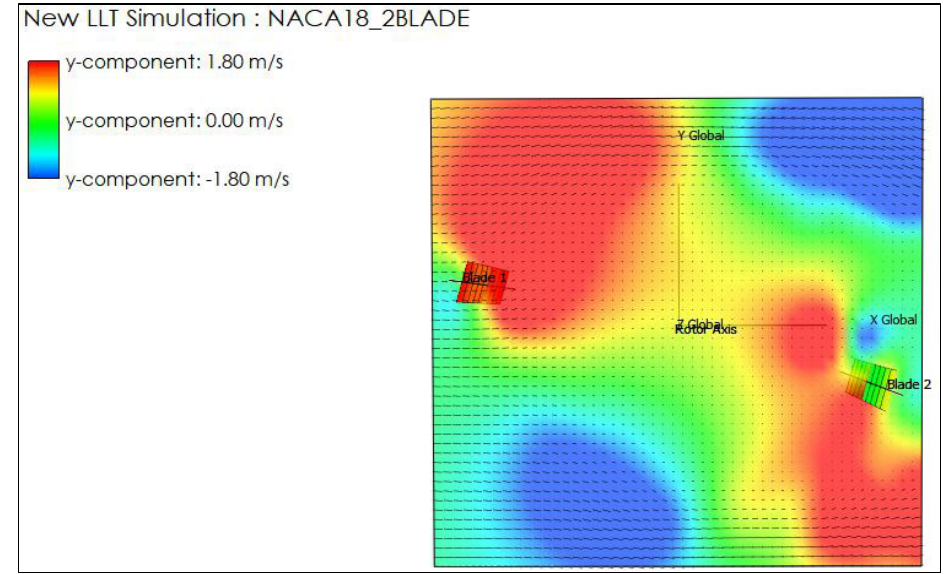
Figure 50. Two-bladed velocity simulation